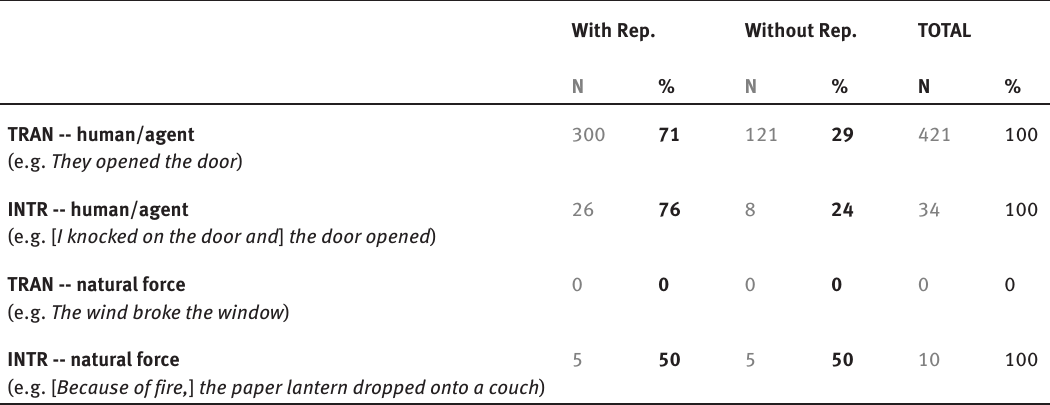
Table 2. Frequencies of representational gestures accompanying the causative-inchoative alternation with human or the natural force as external causation